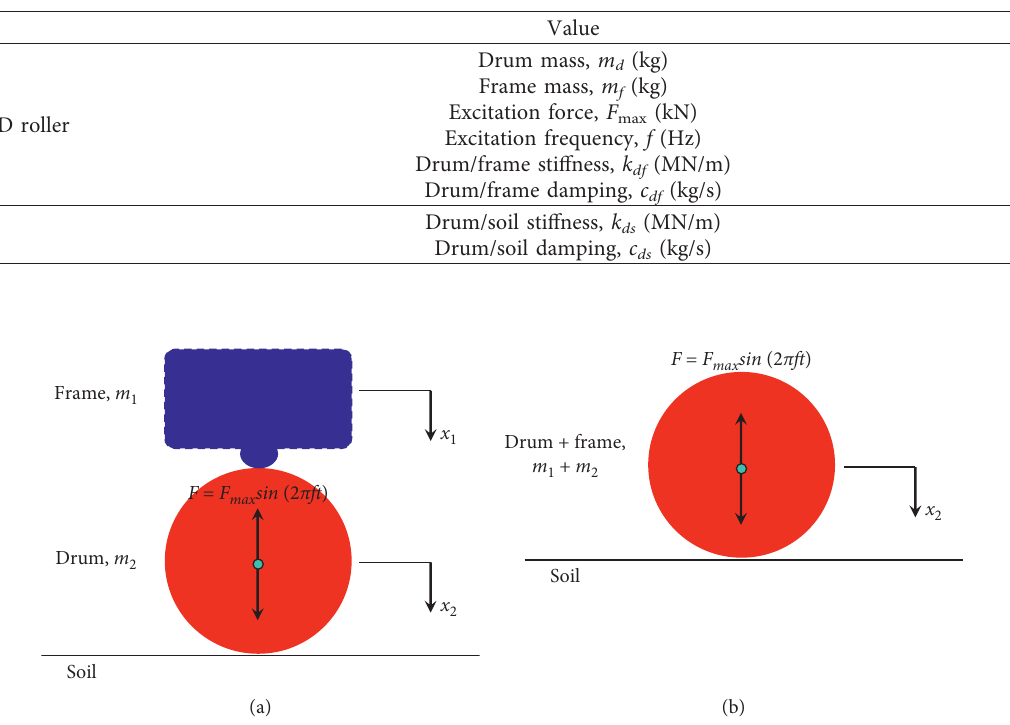
Figure 8: Numerical models for the soil-roller compaction. (a) The roller model in this paper; (b) the roller model in early studies [17, 22,